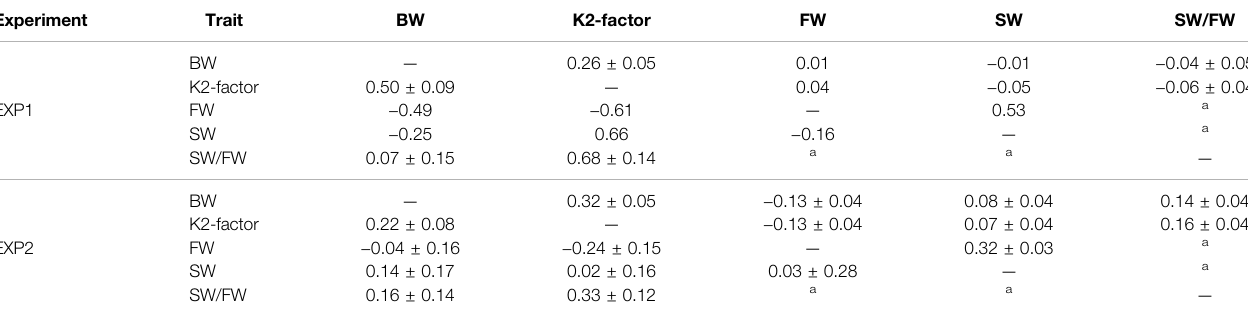
TABLE 4 | Estimates of residual (upper diagonal) and genetic (lower diagonal) correlations ( ± s.e.) between body measurements and smolti fi cation status traits for EXP1 and EXP2 from a multivariate animal model. Experiment